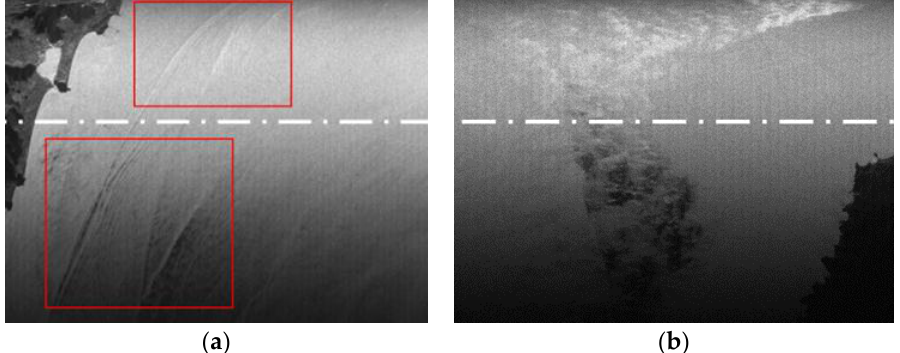
Figure 11. Intensity boundary phenomenon of ( a ) internal waves( as shown in the red boxes ); ( b ) oil slick.